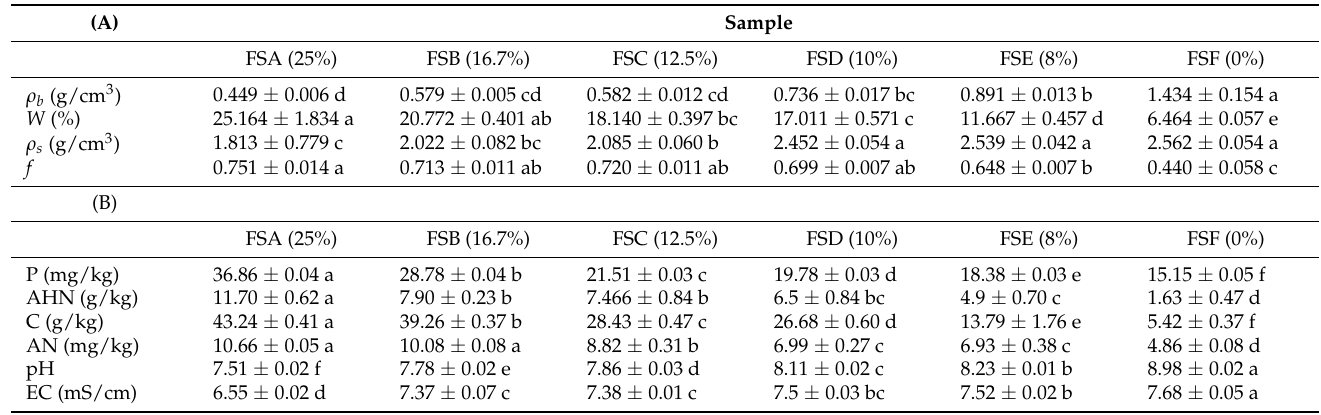
Table 1. Physical (A) and chemical (B) properties of saline-alkali soil improved by adding a GLR organic fertilizer in different proportions. For each row, the means ± SD with different letters were significantly different between treatments ( p < 0.05, using the HSD test).